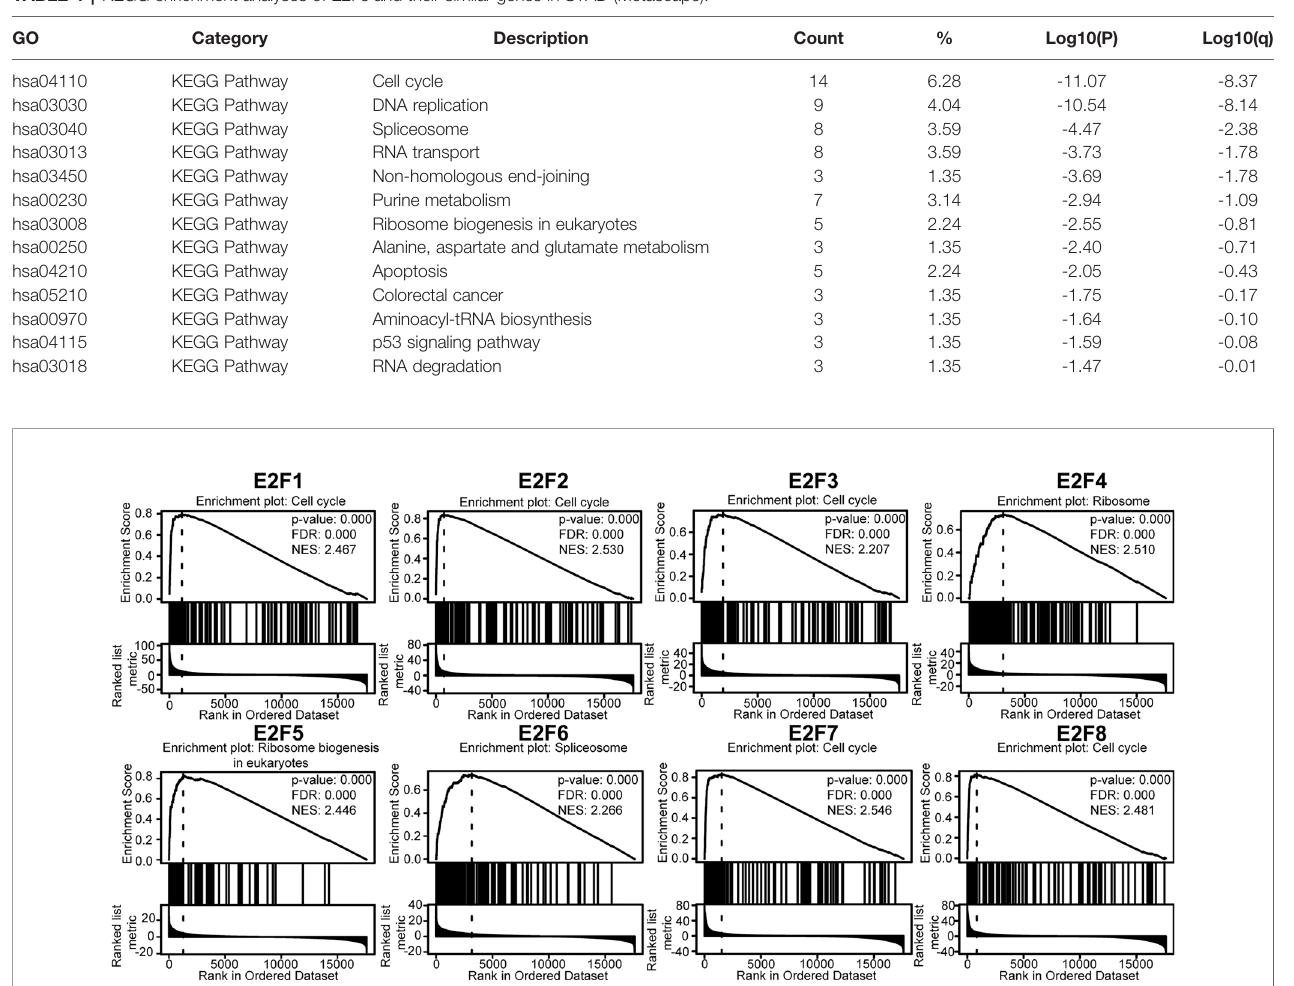
FIGURE 8 | Gene set enrichment analysis (GSEA) of E2Fs (LinkedOmics). TCGA_STAD was selected as the interested cancer cohort, for which RNAseq datatype was selected as search dataset and target dataset. The interesting list was gsea_result_3583_1616921367.rnk. The interesting list contains 17608 unique entrezgene IDs. The expression dataset of 6843 genes related to the expression of E2Fs in 415 samples was used to perform GSEA using the “ LinkInterpreter ” module. The parameters were set as follows: enrichment analysis = KEGG pathway; rank criteria = FDR; minimum Number of Genes (Size) = 3; simulations = 500; p = 0.05; FDR < 0.25, |NES| > 1. The top-ranking enrichment term for each E2F factor was shown. TCGA, the cancer genome atlas; FDR, false discovery rate; NES, normalized enrichment